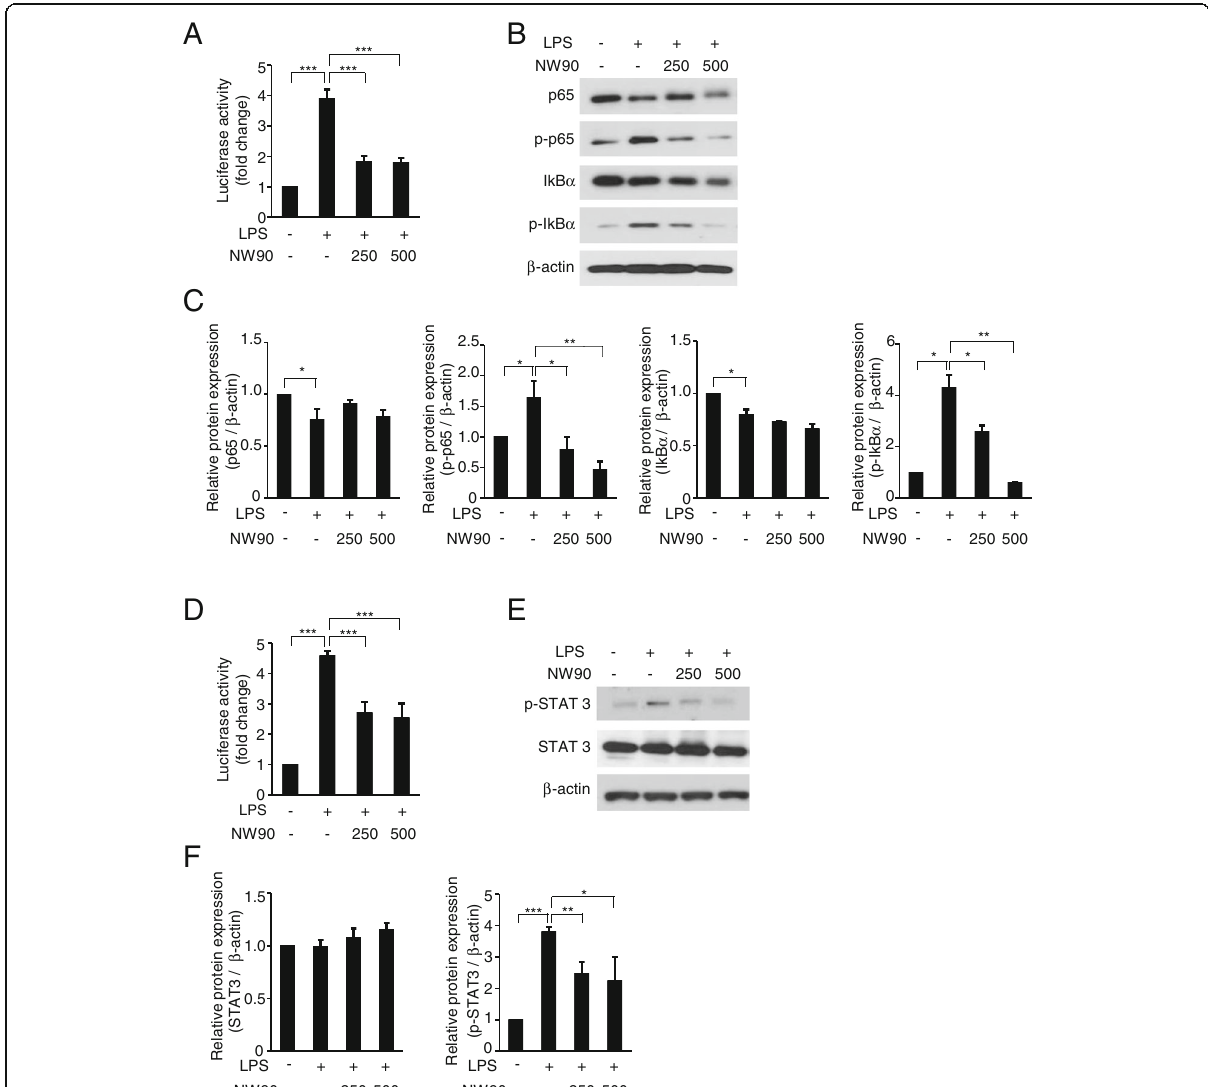
Fig. 4 Effects of Papaver nudicaule extract NW90 on the NF- κ B and STAT3 signaling pathways. a , d RAW264.7 cells transfected with the NF- κ B-Luc or pSTAT3-Luc were treated with NW90 extract (250 and 500 μ g/ml) and LPS (100 ng/ml). Luciferase activities were measured in cell lysates at 3 ( a ) or 24 ( d ) hours after the treatment. Data are presented as mean ± SD from at least three independent experiments in triplicate. b , e Expression and phosphorylation of p65, I κ B α and STAT3 were analyzed by western blotting in the treated RAW264.7 cells as indicated. β -actin was used as an internal control. c , f Quantification of p65, p-p65, I κ B α , p-I κ B α , STAT3, and p-STAT3 expression with normalization to the β -actin protein levels were analyzed by densitometry analysis of every band using the ImageJ software. Data are presented as mean ± SD from at least three independent experiments. * P < 0.05, ** P < 0.01 and *** P < 0.001 indicate statistically significant differences compared with the group treated